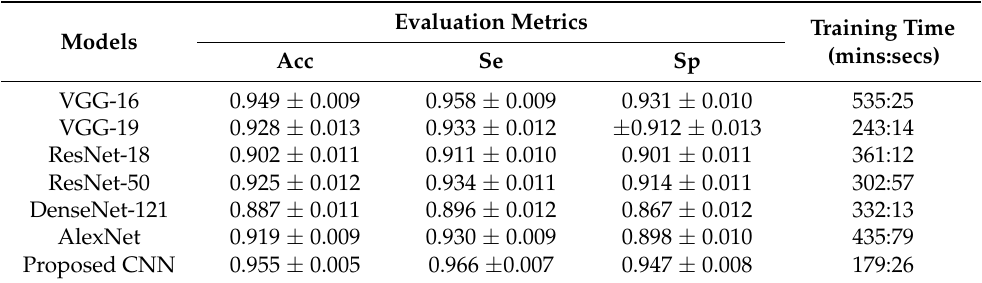
Table 8. The results of different models on the testing set in the RS dataset + NG dataset during the 10-fold cross-validation (mean ± standard deviation).